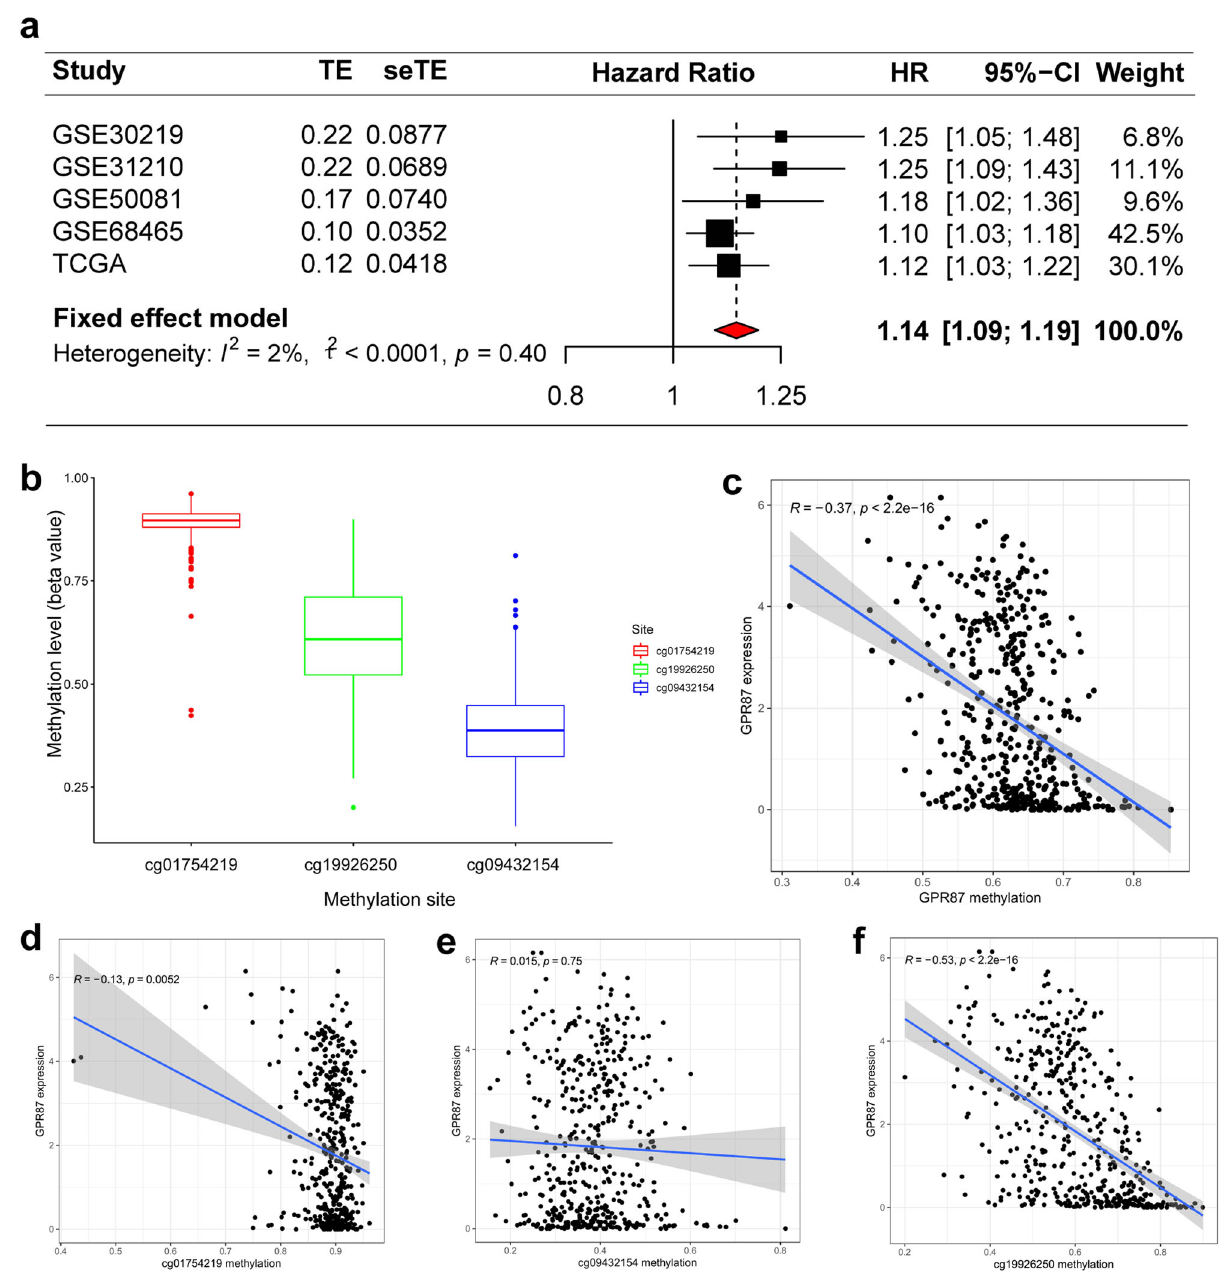
Fig. 5 GPR87 methylation and its effects on prognosis in LUAD tissues were revealed by bioinformatics analysis. a Forest plots of high GPR87 expression from the four datasets with worse OS in LUAD patients. b Distribution of GPR87 promoter CpG sites. c Correlation analysis between GPR87 methylation and expression levels. d – f Correlation analysis between methylation levels of CpG sites and GPR87